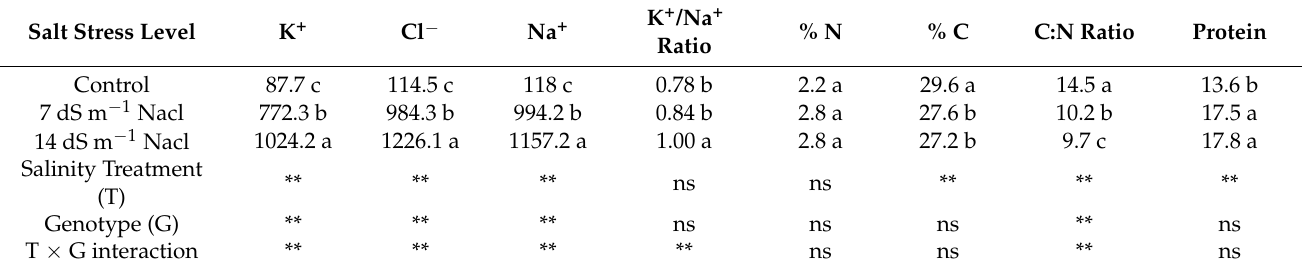
Table 5. Effect of salt stress on biomass and agro-physiological traits, and yield components across 6 barley genotypes.